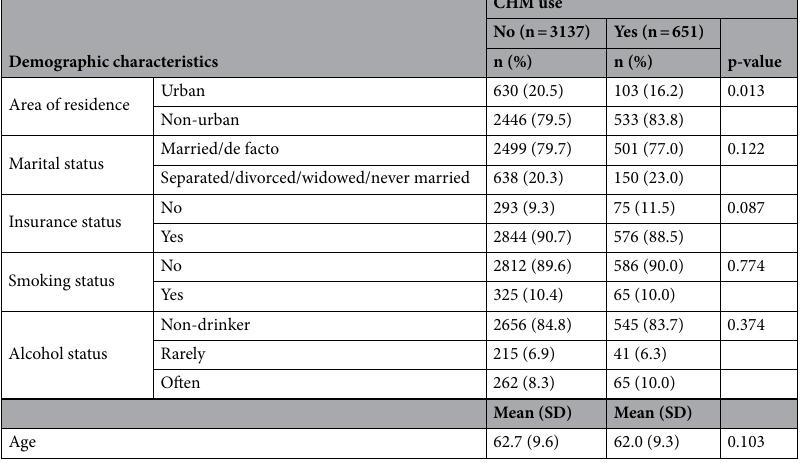
Table 3. CHM users were more likely to visit a specialized hospital (p = 0.013) and/or a Chinese medicine hos- pital (p < 0.001). In addition, CHM users were more likely to self-purchase over-the-counter Western medicine